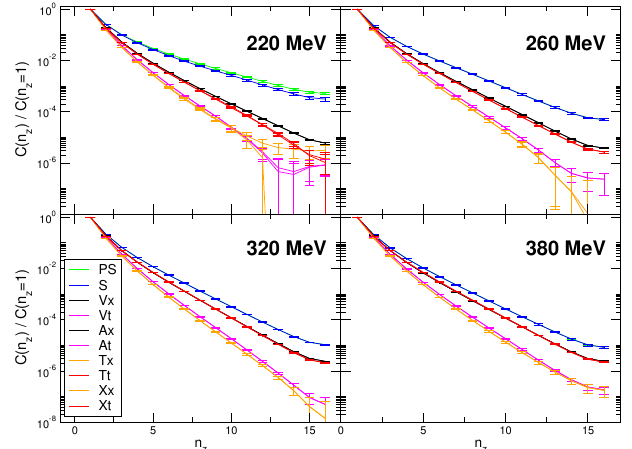
Figure 4. Normalized spatial correlators. The figure is from Ref.